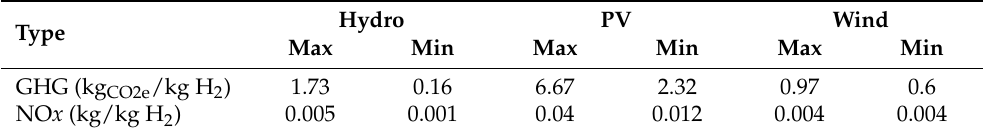
Table 2. GHG and NO x emissions of green hydrogen.